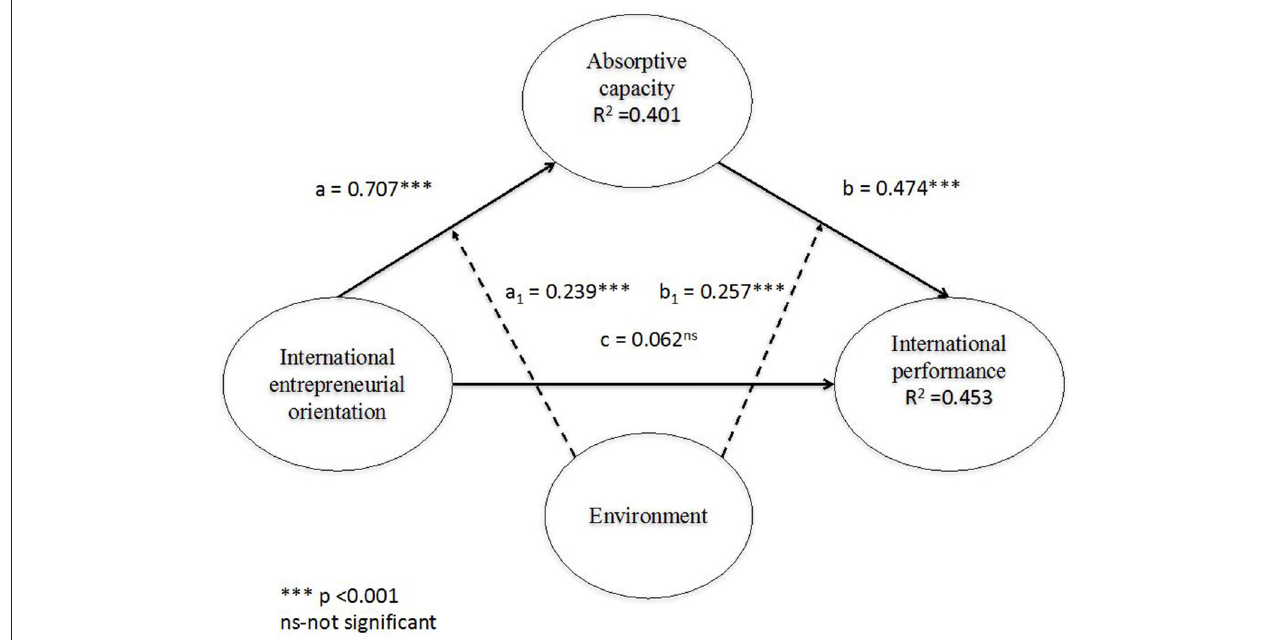
FIGURE 5 | Conditional mediation